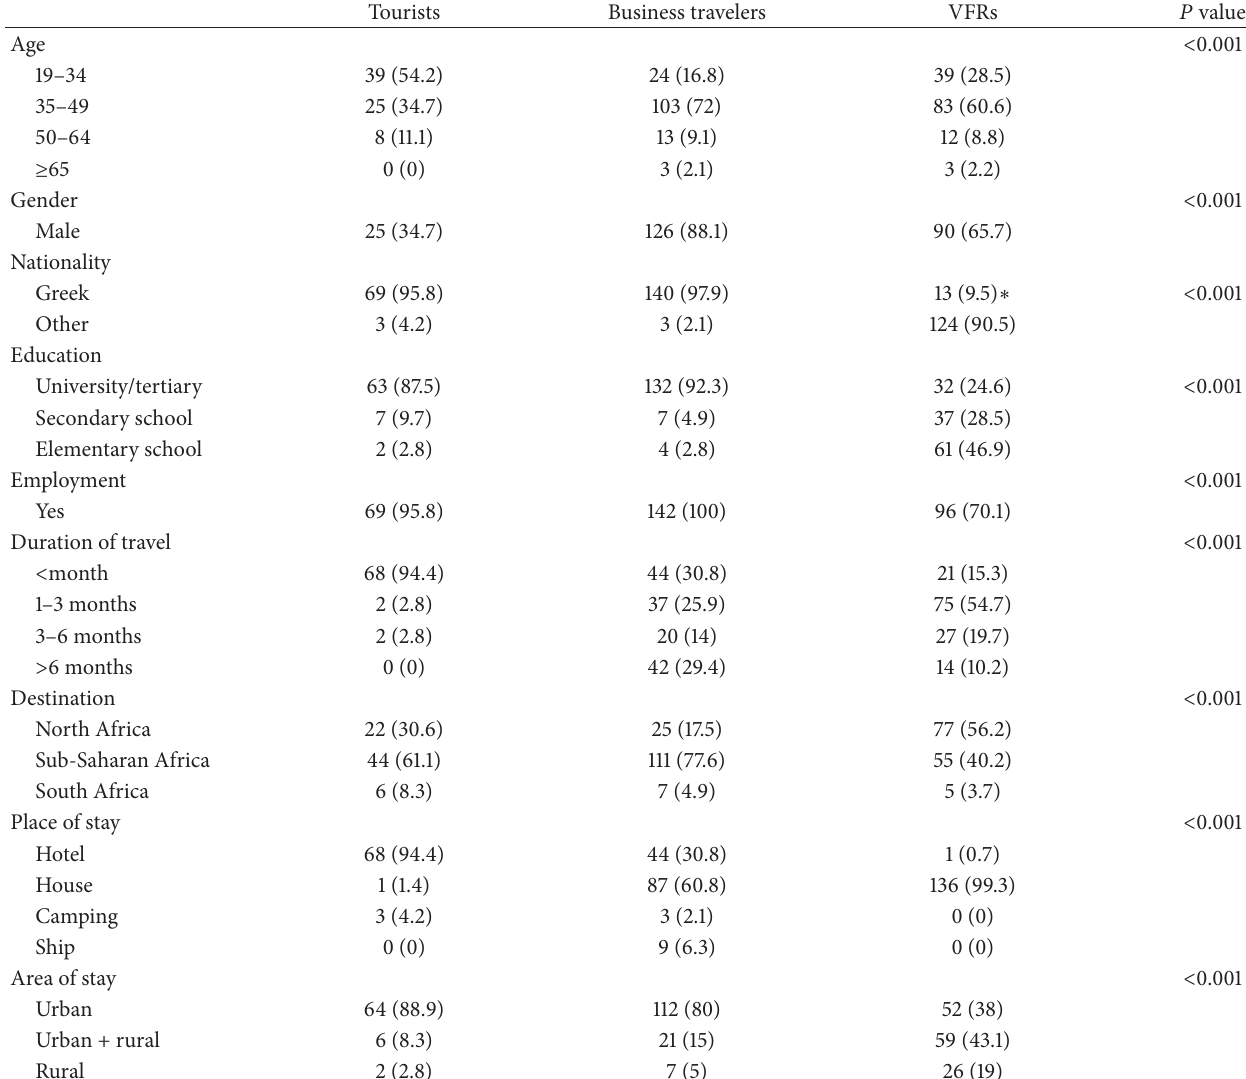
Table 4: Travelers and travel characteristics by purpose of